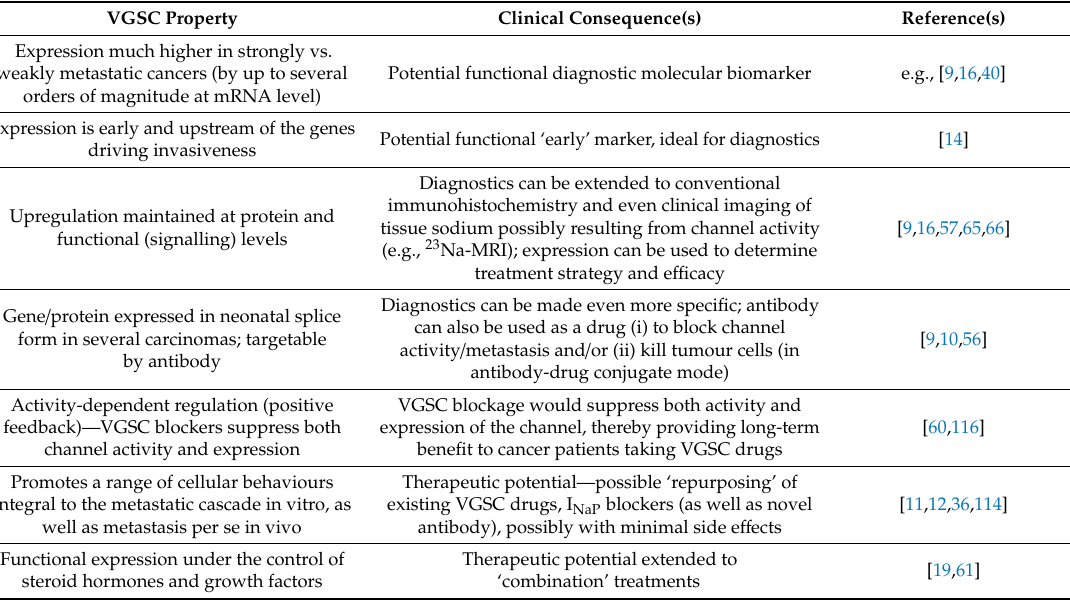
Table 2. Essential properties of the VGSC that would make it a clinically viable anti-metastatic target. VGSC Property Clinical Consequence(s) Reference(s) Potential functional diagnostic molecular